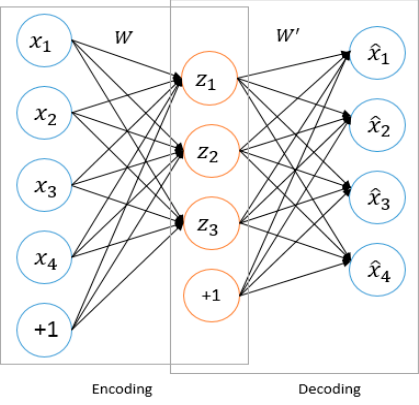
Figure 34. Diagram for Auto encoder.